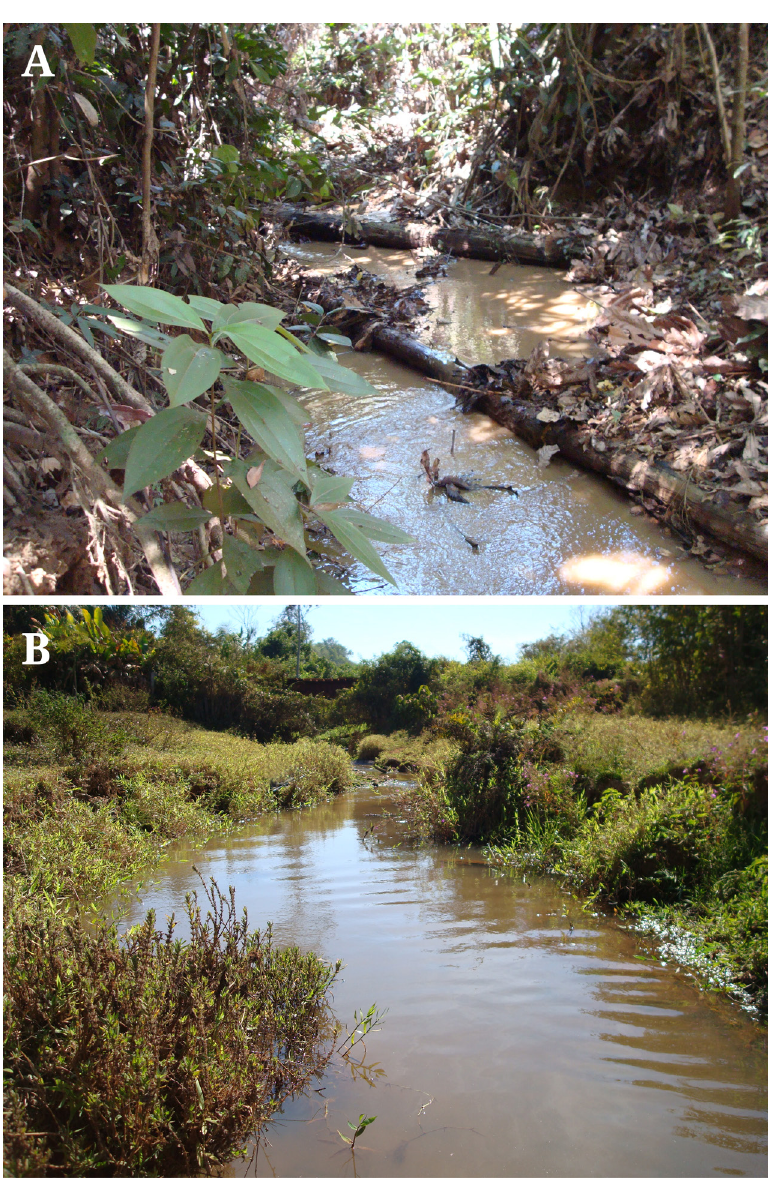
FIGURE 5 | General view of streams where Inpaichthys kerri ( A ) and Hyphessobrycon vilmae ( B ) individuals were collected in the Aripuanã River basin, Mato Grosso State,